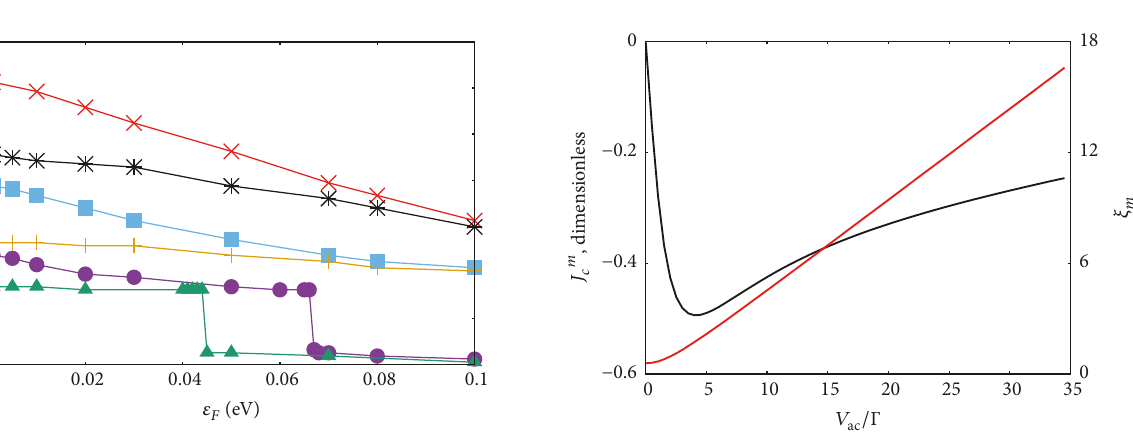
Figure6:Maximumabsolutevalueofthenegativeactivecurrent 𝐽 𝑐𝑚 (black line, left 𝑦 -axis) and its position relative to the energy of the resonant level 𝜉 𝑚 = (𝜀−𝜀 𝑅 )/Γ (red line, right 𝑦 -axis) as a function of amplitude of the AC electric field in the model with monoenergetic electrons at the frequency ℎ𝜔 = 0.1Γ